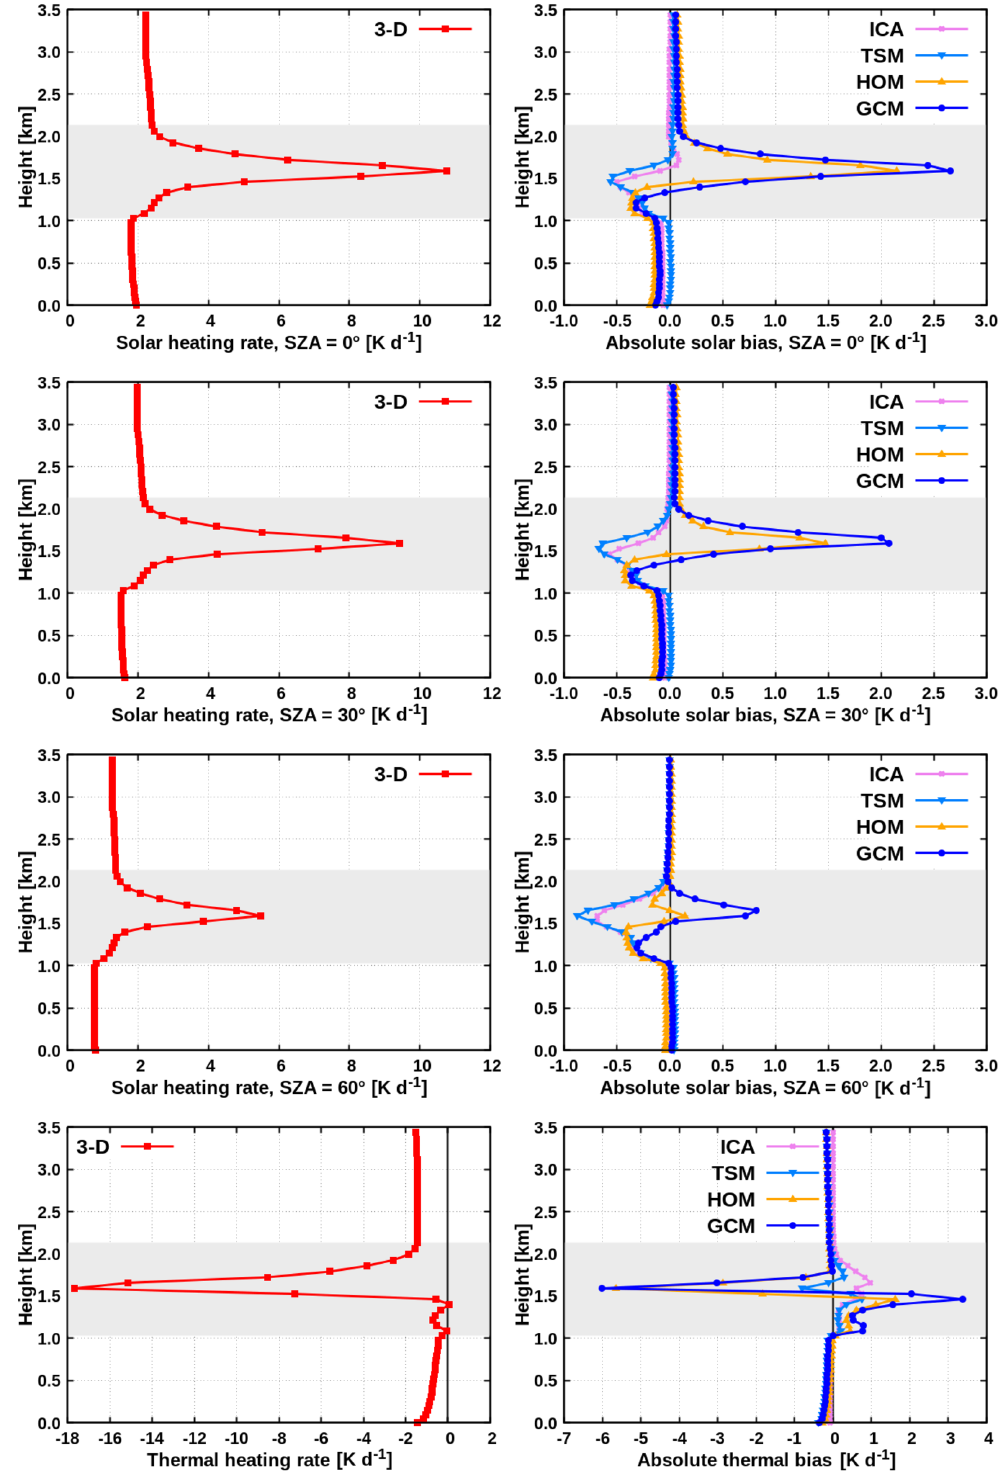
Figure 5. Radiative heating rate in preliminary experiments. The cloud layer is shaded